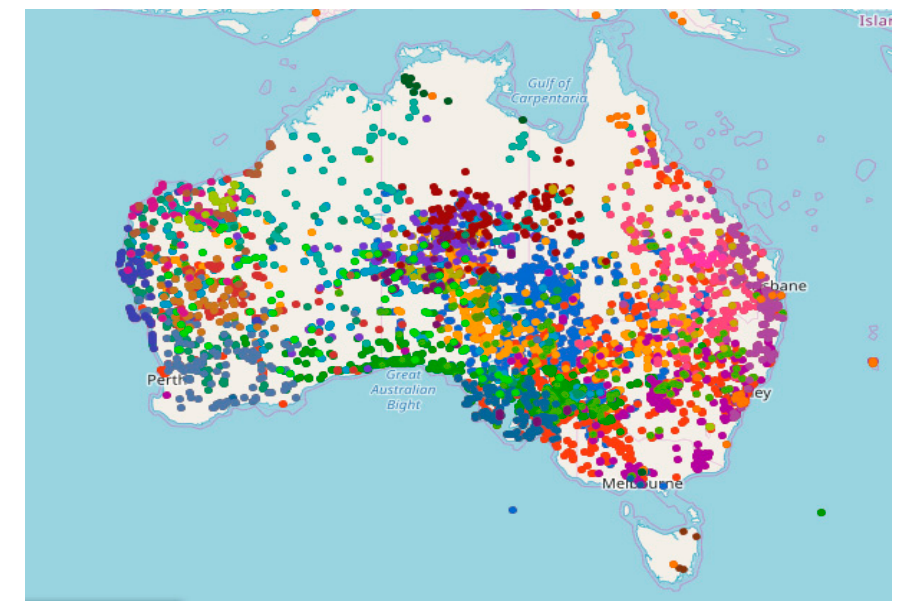
Figure 1. General dispersal of Australian Nicotiana spp. [2].